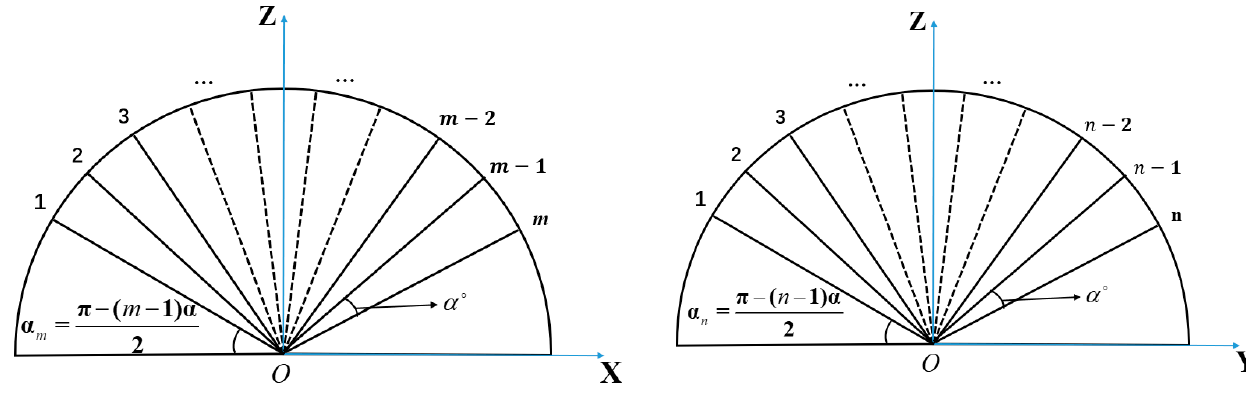
Figure 2. m × n spherical CAA angle calculation model.